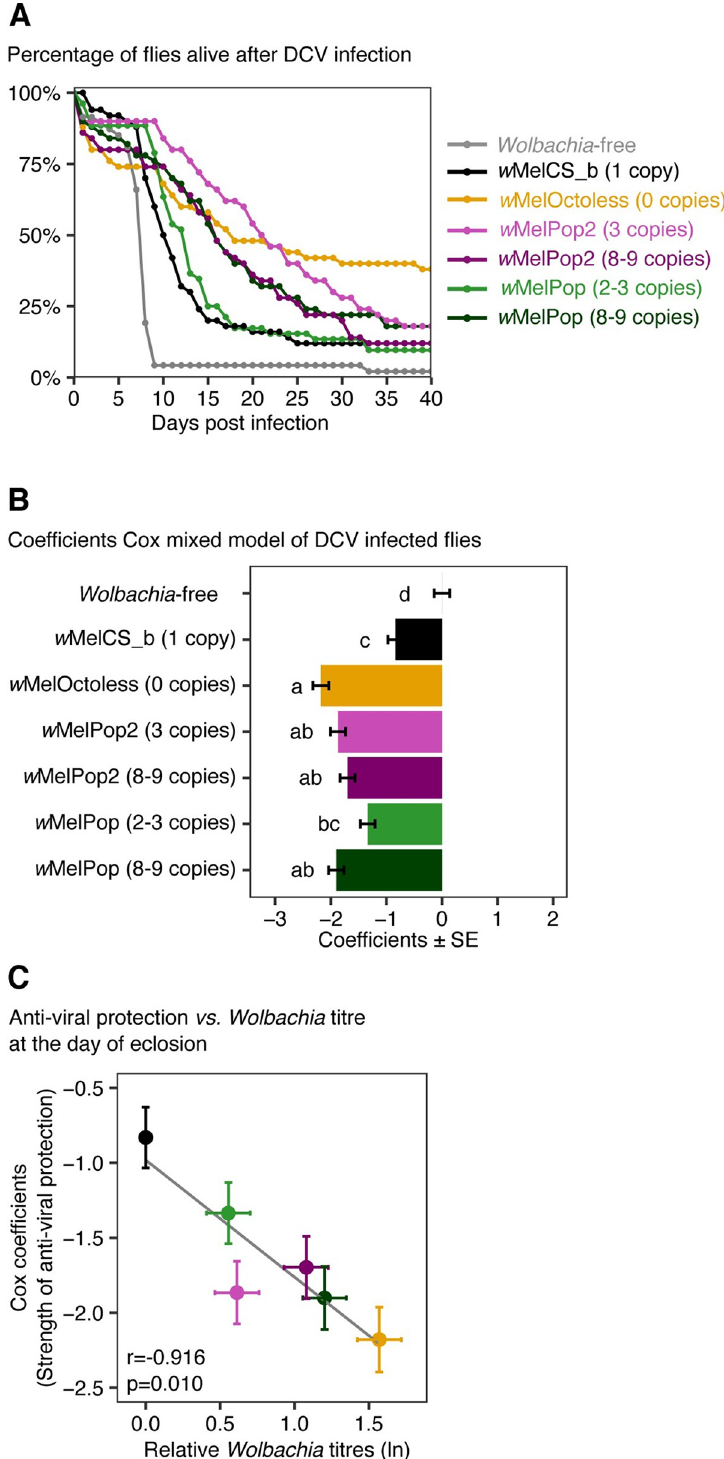
Fig 6. w MelOctoless and w MelPop2 provide strong protection against DCV. (A) Survival of males carrying different Wolbachia variants after a challenge with DCV. Fifty 3–5 day-old Drosophila males, per line, were pricked with DCV (10 9 TCID 50 /ml) and survival followed for 40 days, at 18˚C. A replicate of the experiment and the buffer- pricked controls are shown in S17 Fig. (B) Coefficients of Cox mixed models of DCV-infected flies. Cox